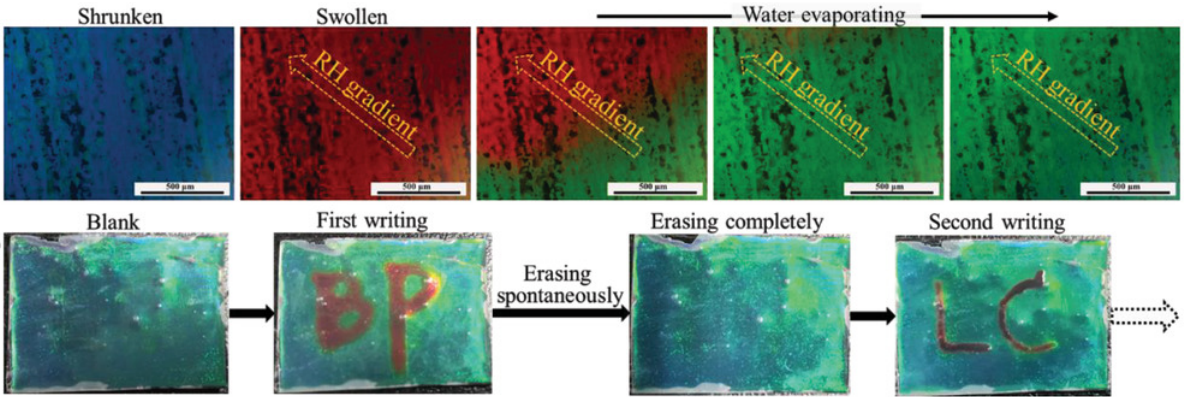
Figure 10. POM images of writing tablet model, photographs showing the responsive behaviors. ( a ) POM images of the color changing with the RH. ( b ) Photographs of the writing and erasing perfor- mance of the film [92]. Humidity-Responsive Blue Phase Liquid-Crystalline Film with Reconfigurable and Tailored Visual Signals from Yang, Advanced Functional Materials, published by John Wiley and